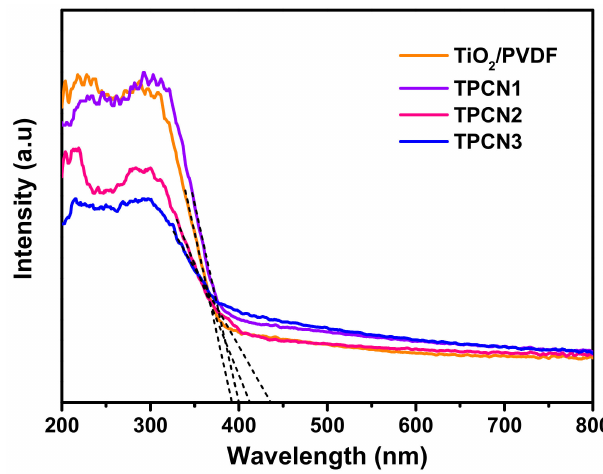
Figure 6. UV-Vis absorption spectra of TiO 2 / PVDF and various as-prepared TPCN